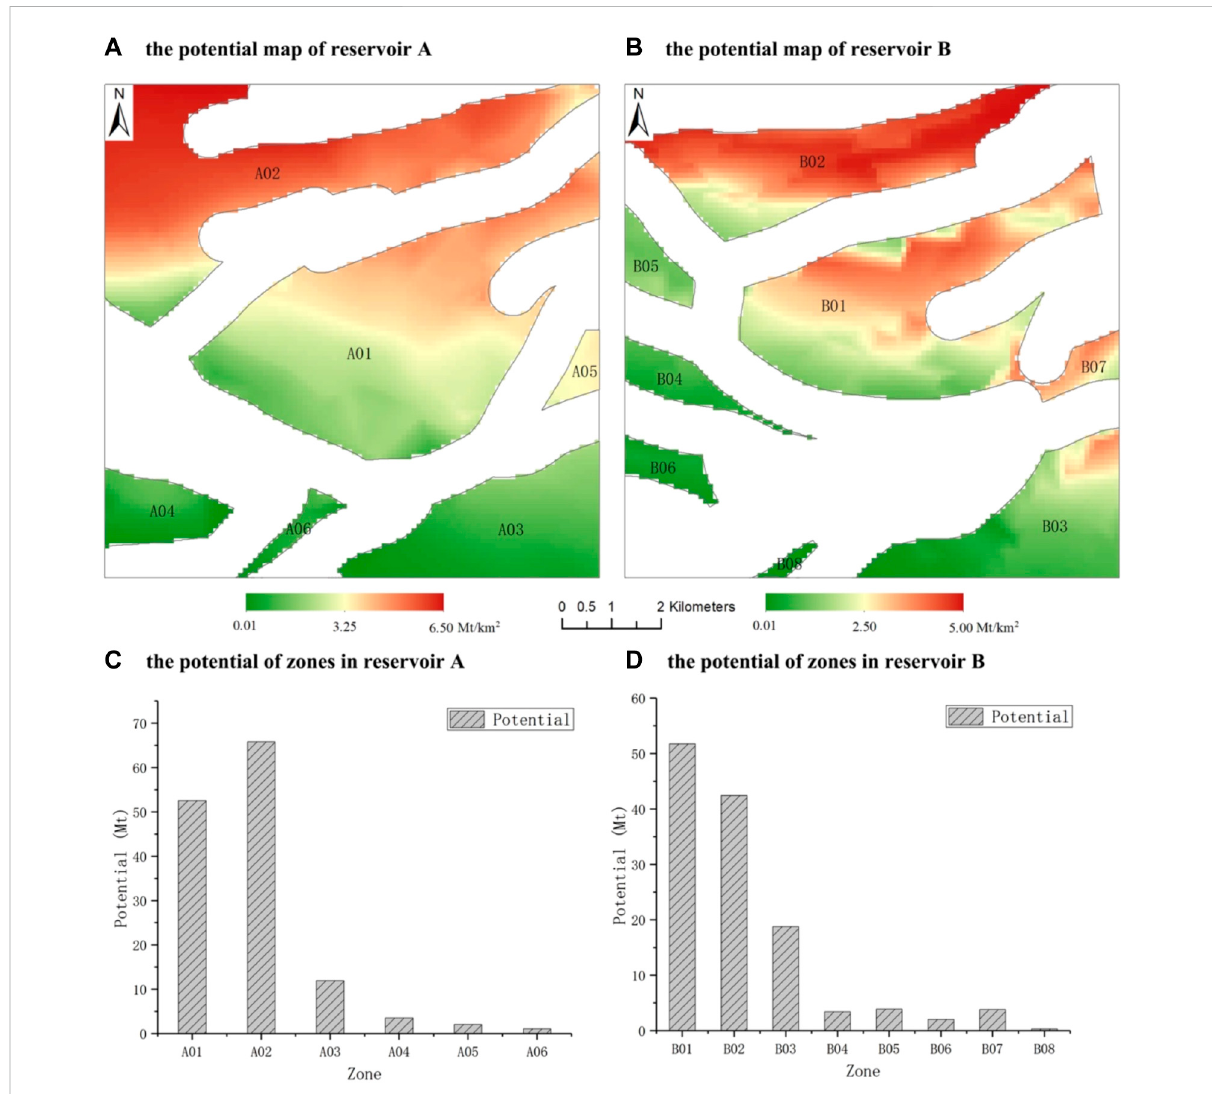
FIGURE 17 The location of the spatial distribution of CO 2 at the 100-year moment ( V a ≈ 160